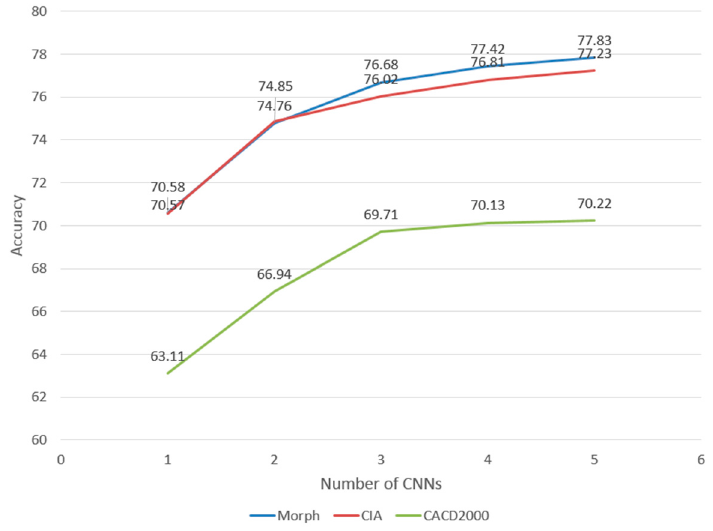
Figure 14. Age range recognition accuracy in multiple (1~5) CNNs with EFI.